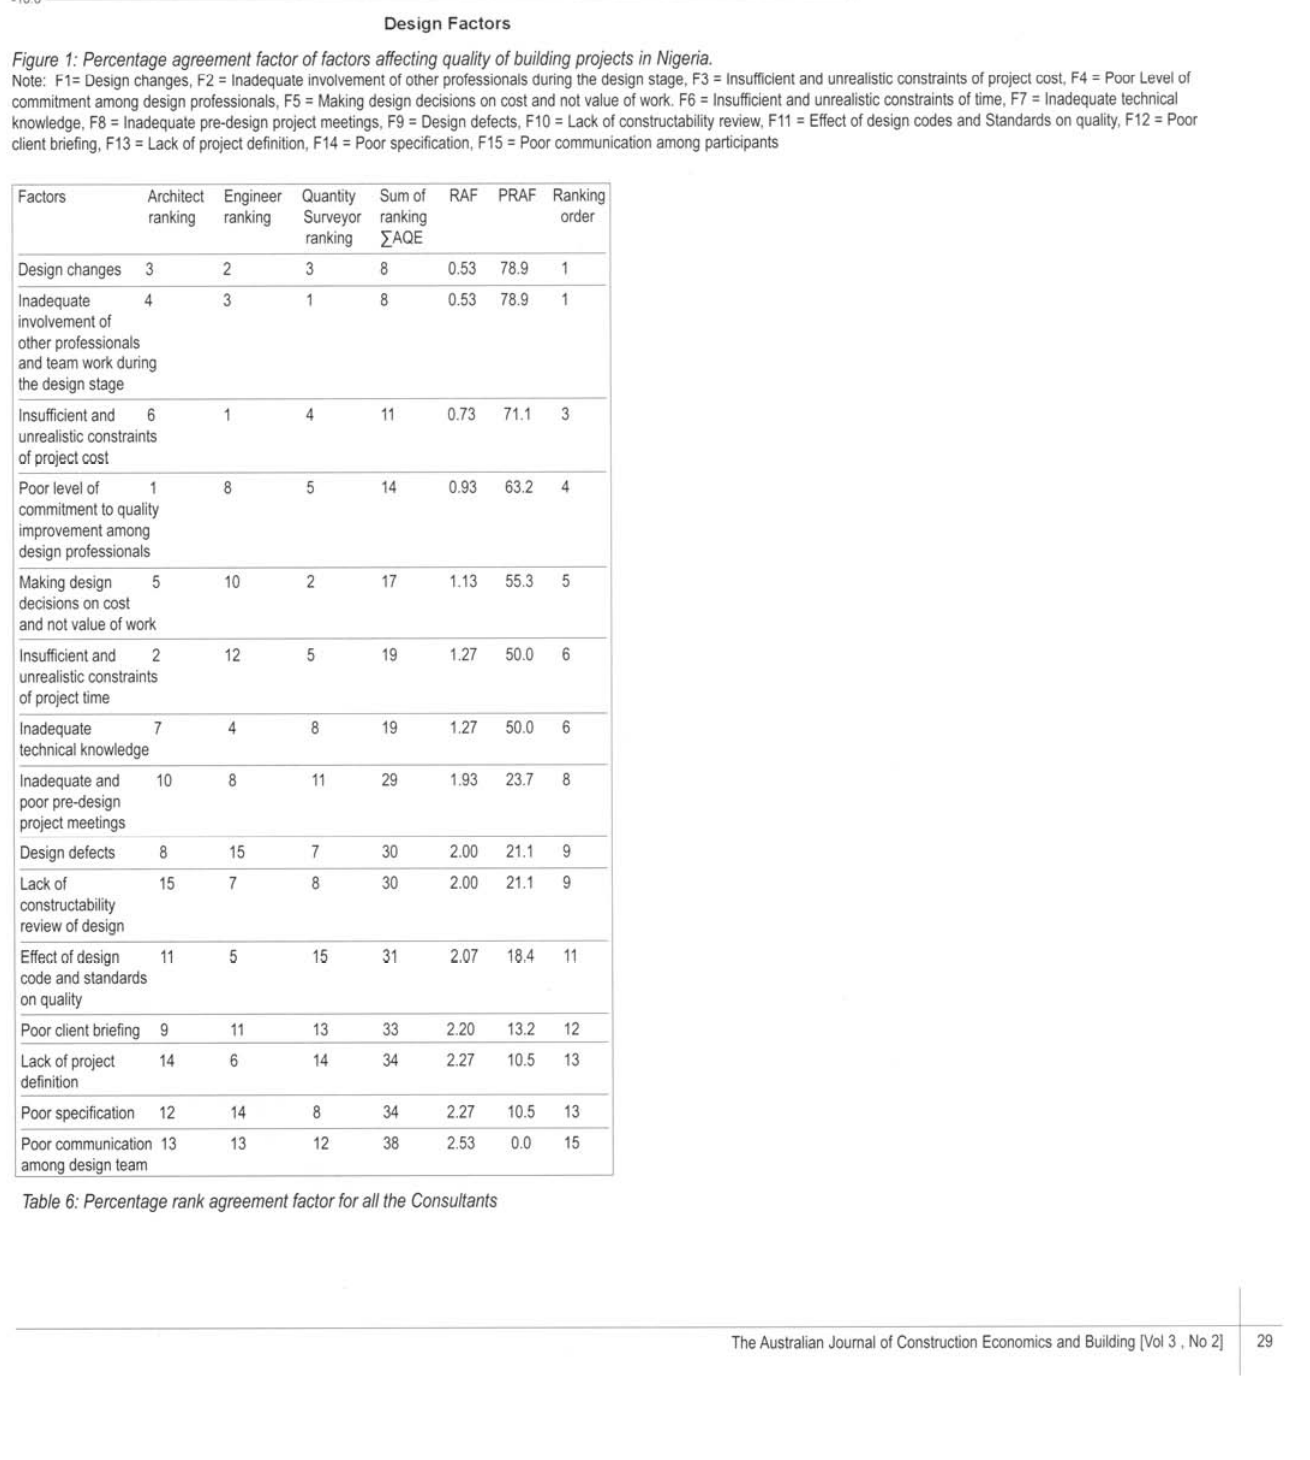
Table 6: Percentage rank agreement factor for all the